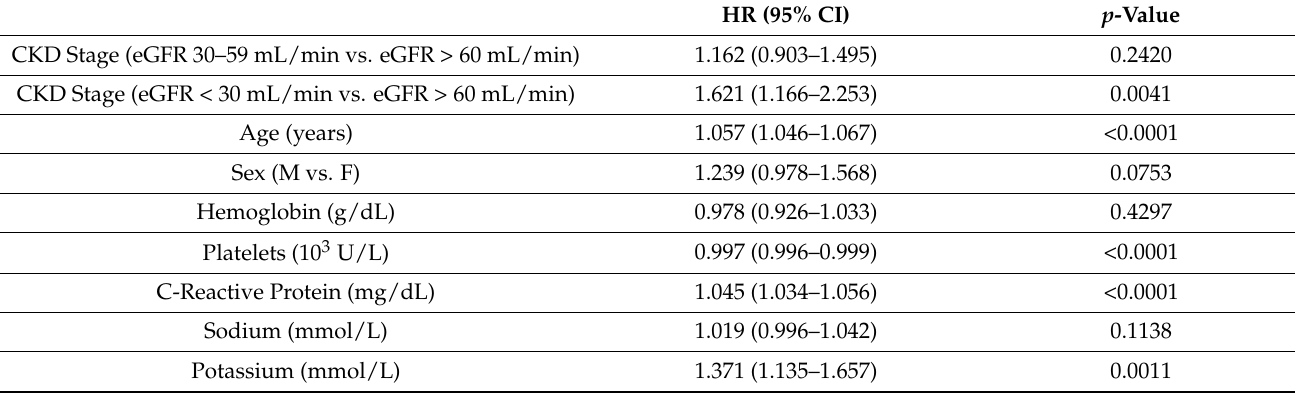
Table A2. Cox proportional hazards model on the impact of laboratories measurements on in-hospital mortality. Confound- ing variables with a significance level of <0.1 were retained in the final model. n = 2217, death = 369. HR (95% CI)